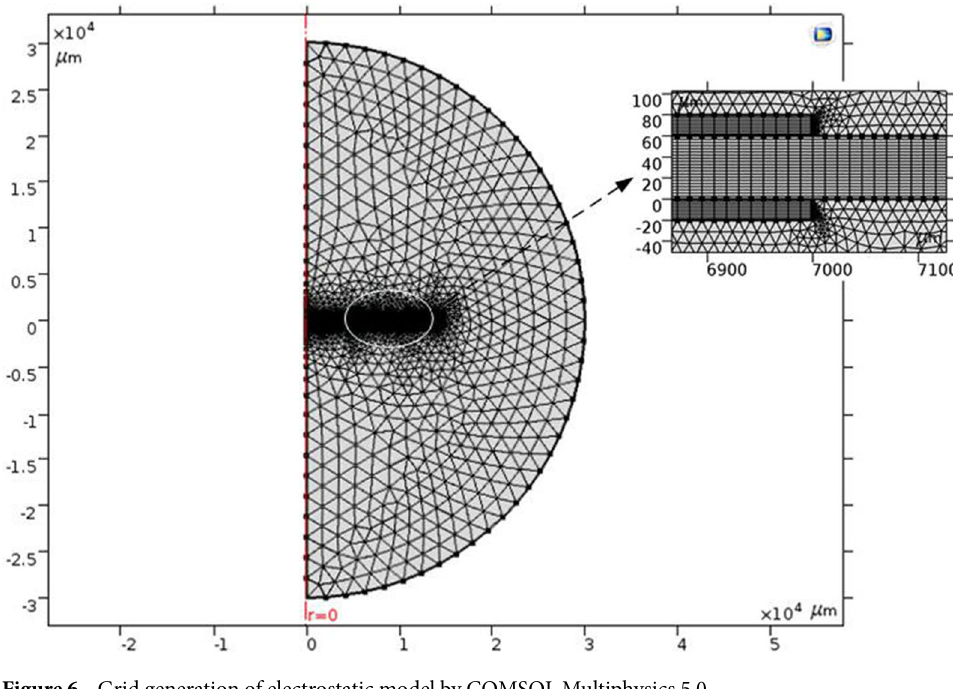
Figure 6. Grid generation of electrostatic model by COMSOL Multiphysics 5.0.